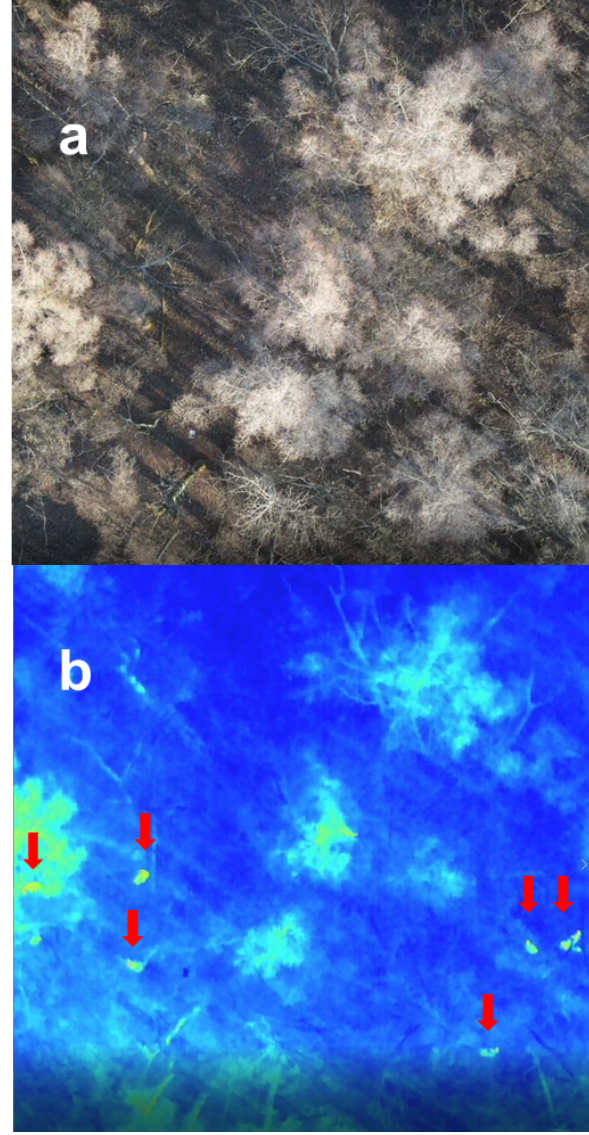
Figure 7 . Screen shots of movie files acquired by M2EA; RGB image (a) of a sparse larch stand and thermal image of the same area (b). Colors are shown as relative temperatures, with higher temperatures from blue to red. Red arrow indicates sika deer